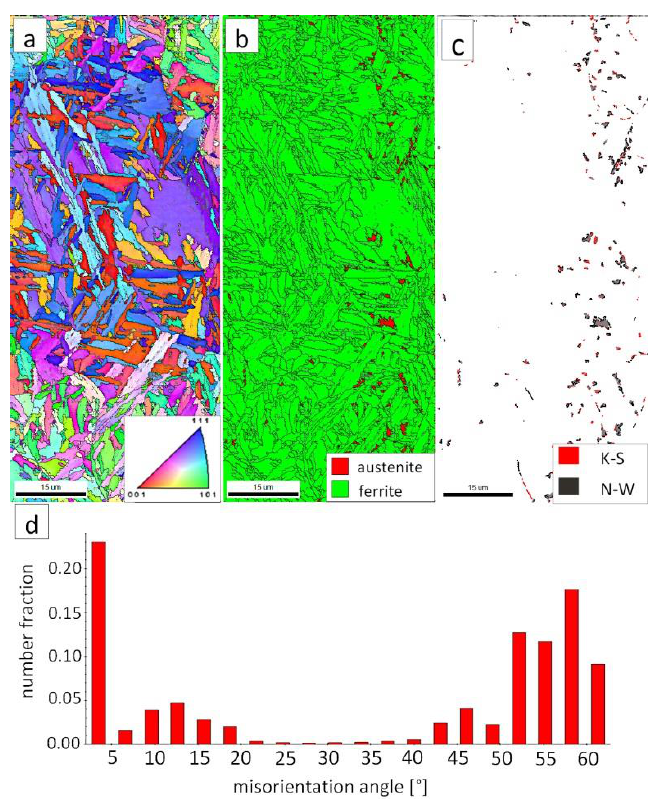
Figure 15. ( a ) IPF map of the BM. ( b ) Phase distribution map of the BM. ( c ) Phase distribution map with indicated boundaries of N-W (marked in black) and K-S (marked in black) orientations. Ferrite-white, austenite-gray. ( d ) Misorientation angles distribution of the BM.